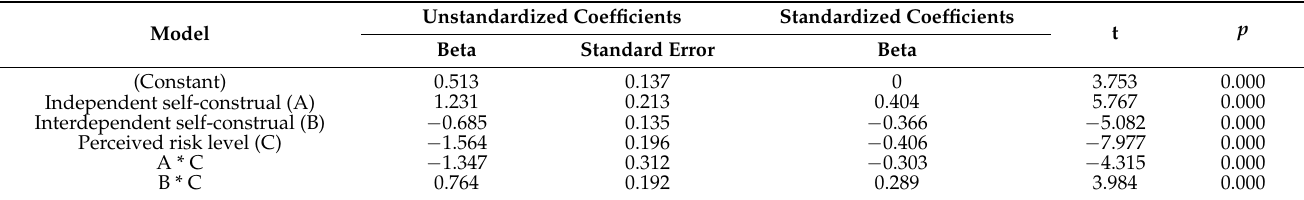
Table 4. Results of technology readiness regression analysis on different self-construals and perceived risk level.